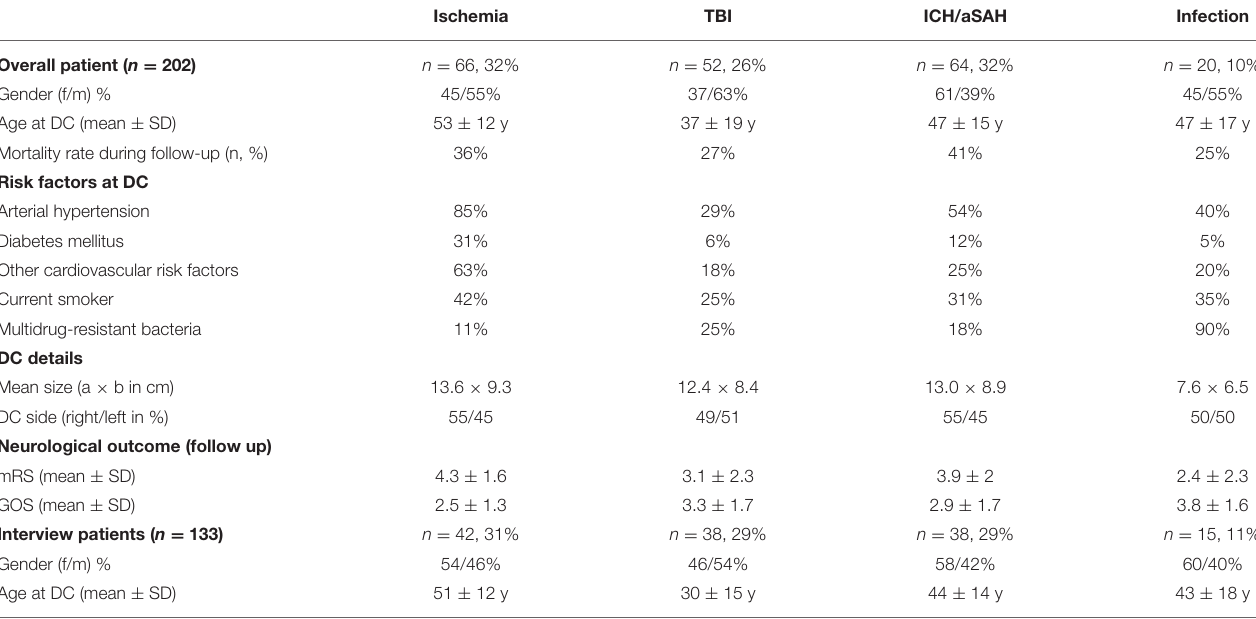
TABLE 1 | Patient population, specific risk factors, and neurological outcome after CP. Ischemia TBI ICH/aSAH Infection